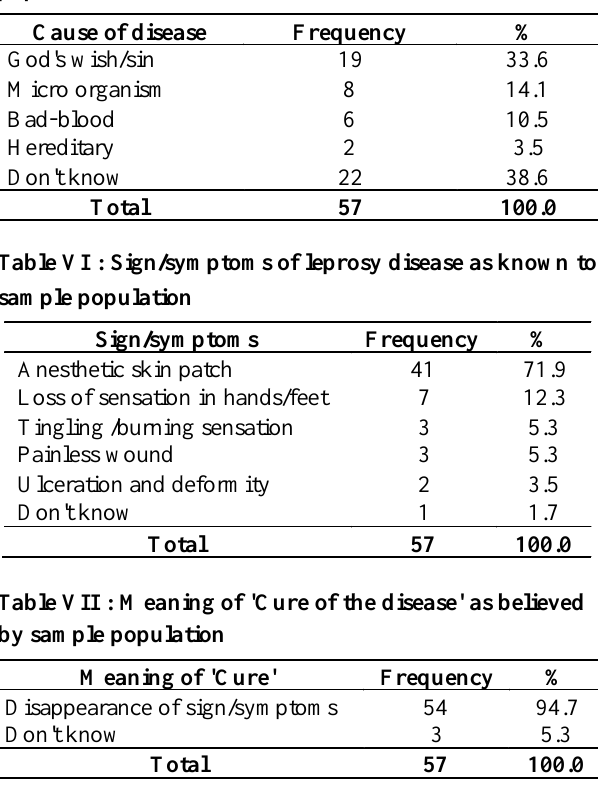
Table V : Cause of disease as known to the sample